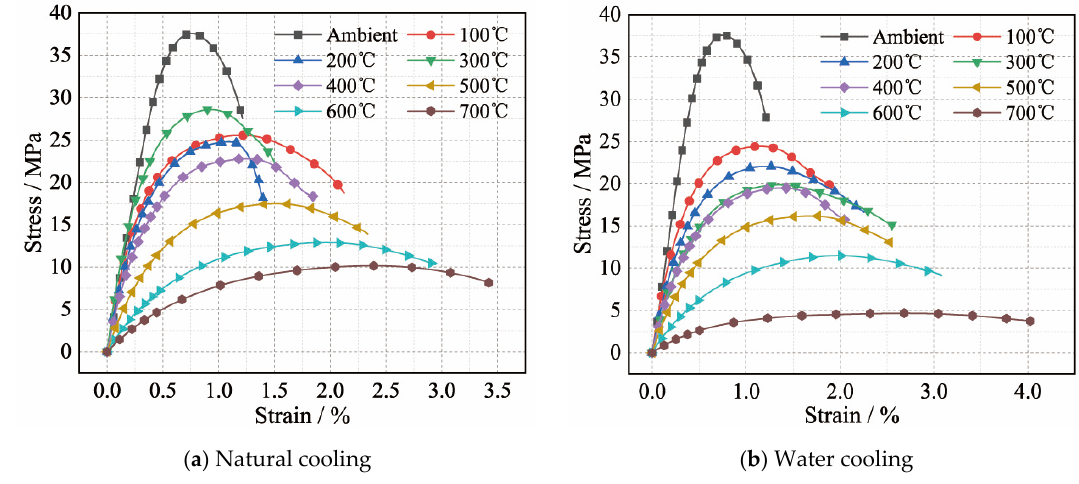
Figure 9. The stress–strain curves of the SCC specimens after cooling.